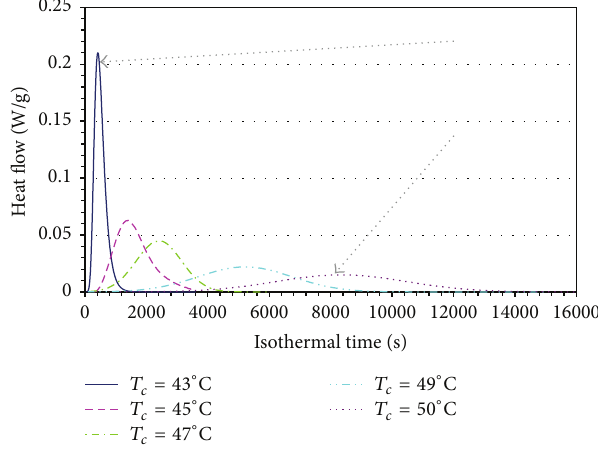
Figure 2: Experimental DSC tests.